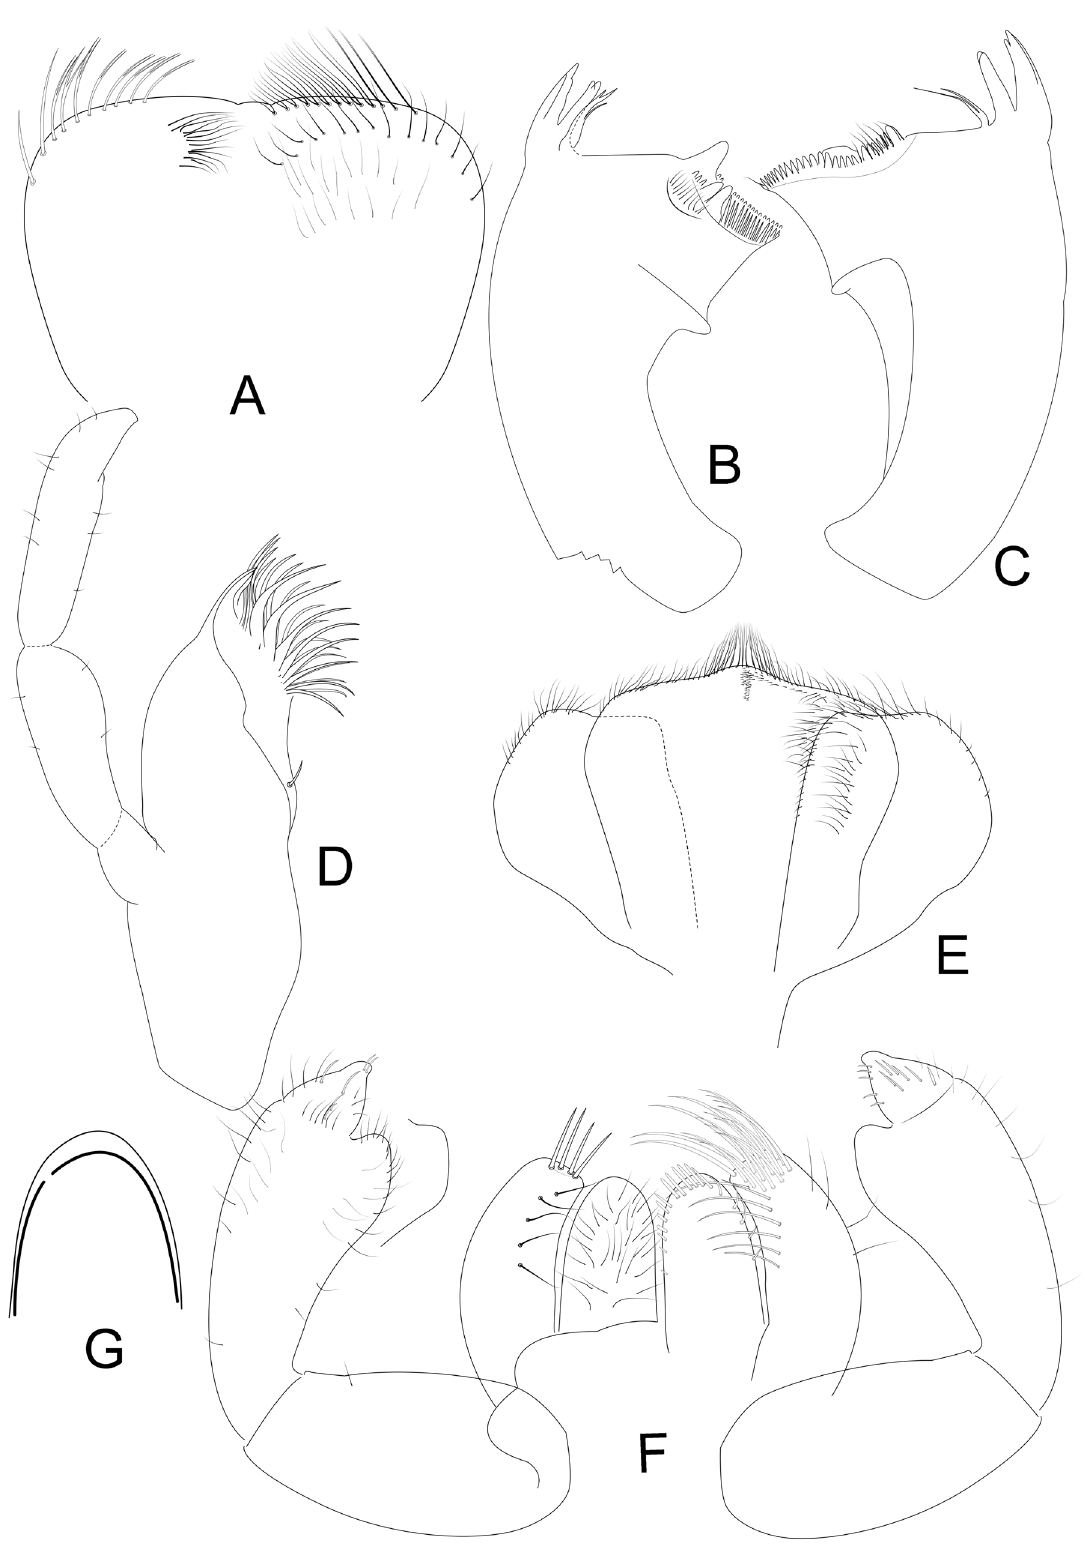
Fig. 16. Rivudiva naia sp. nov., holotype (UFRR). A . Labrum (left v.v., right d.v.). B . Left mandible. C . Right mandible. D . Maxilla. E . Hypopharynx. F . Labium (left v.v., right d.v.). G . Shape of distal rows of setae of glossa. Not to